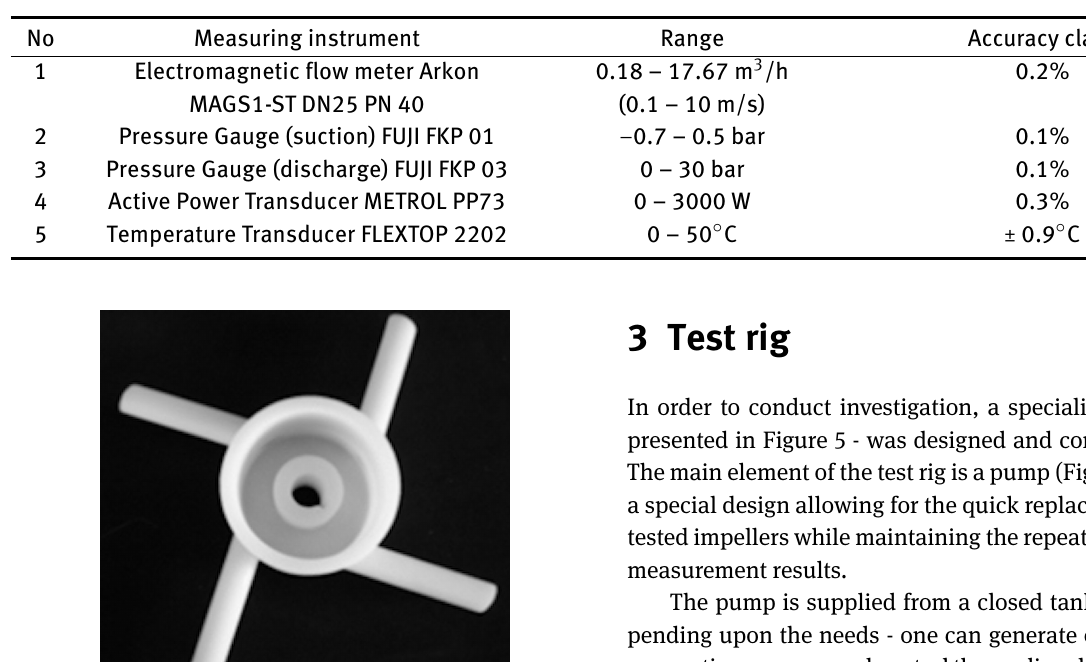
Table 2: Measuring instruments [9]